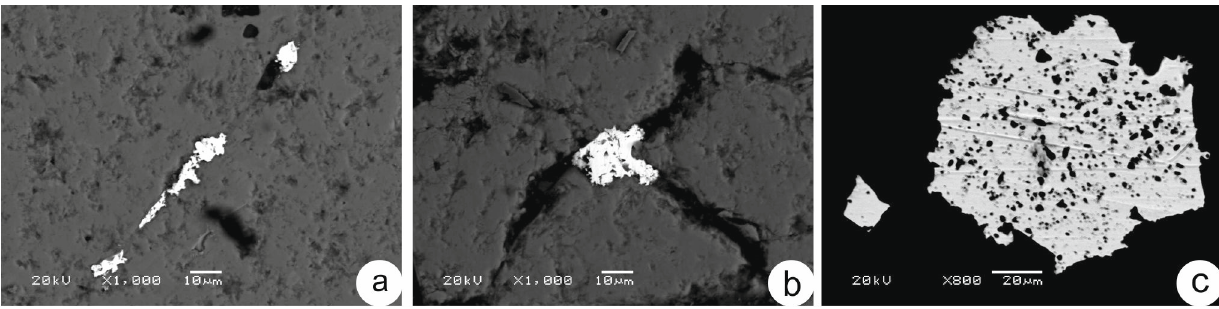
Figure 7. Morphology of native gold of primary ores: ( a )—interstitial between pyrite grains; ( b )— cementing along cracks in pyrite; ( c )—interstitial pseudoidiomorphic grains of hexagonal appear- ance.